Question: State the chart type depicted above.
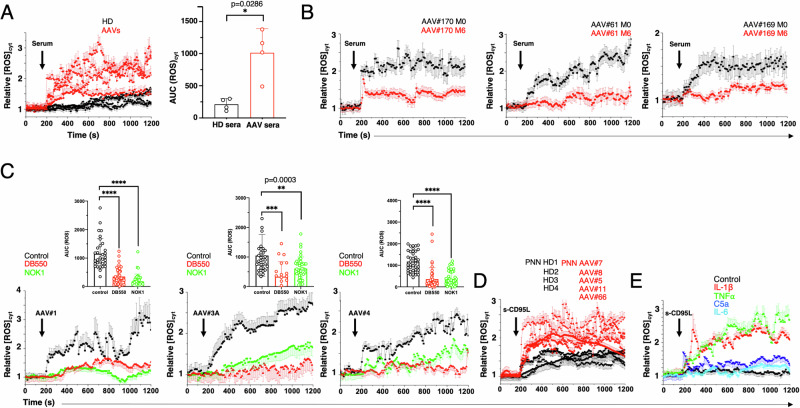
Answer: histogram